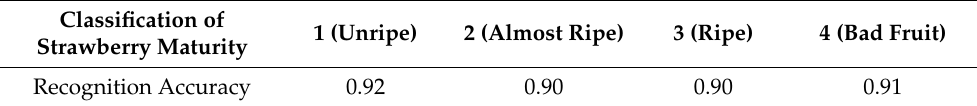
Table 5. Test results of strawberries of different maturity categories.